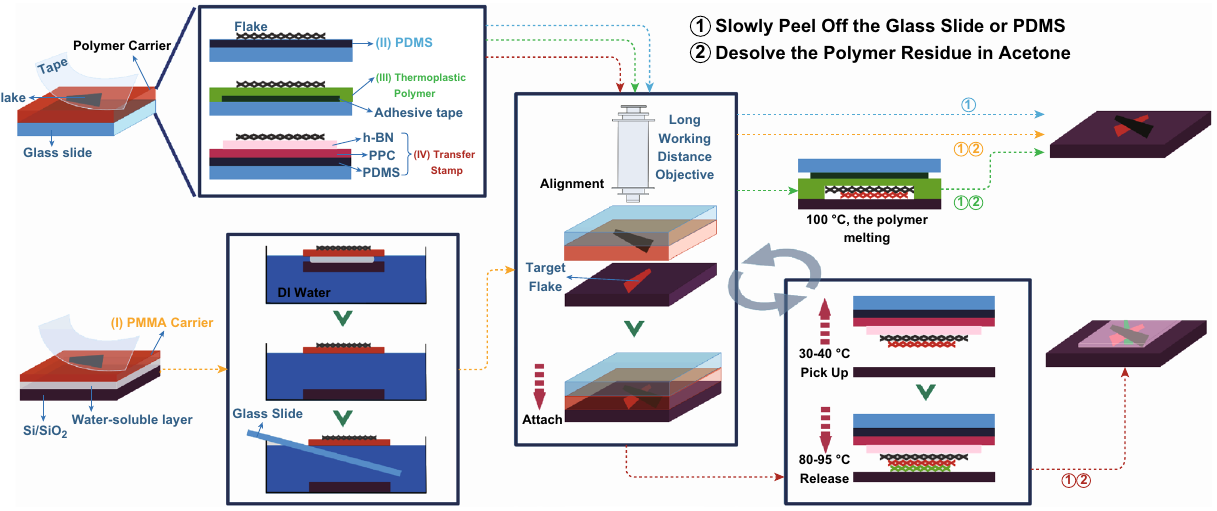
Fig. 1 The deterministic transfer method. The yellow, blue, green, and red dashed lines correspond to the process of transfer using polymer car‑ riers of types I to IV, respectively, and in the end a bare heterostructure or a multilayer heterostructure covered by hBN will be fabricated. (Color figure online)